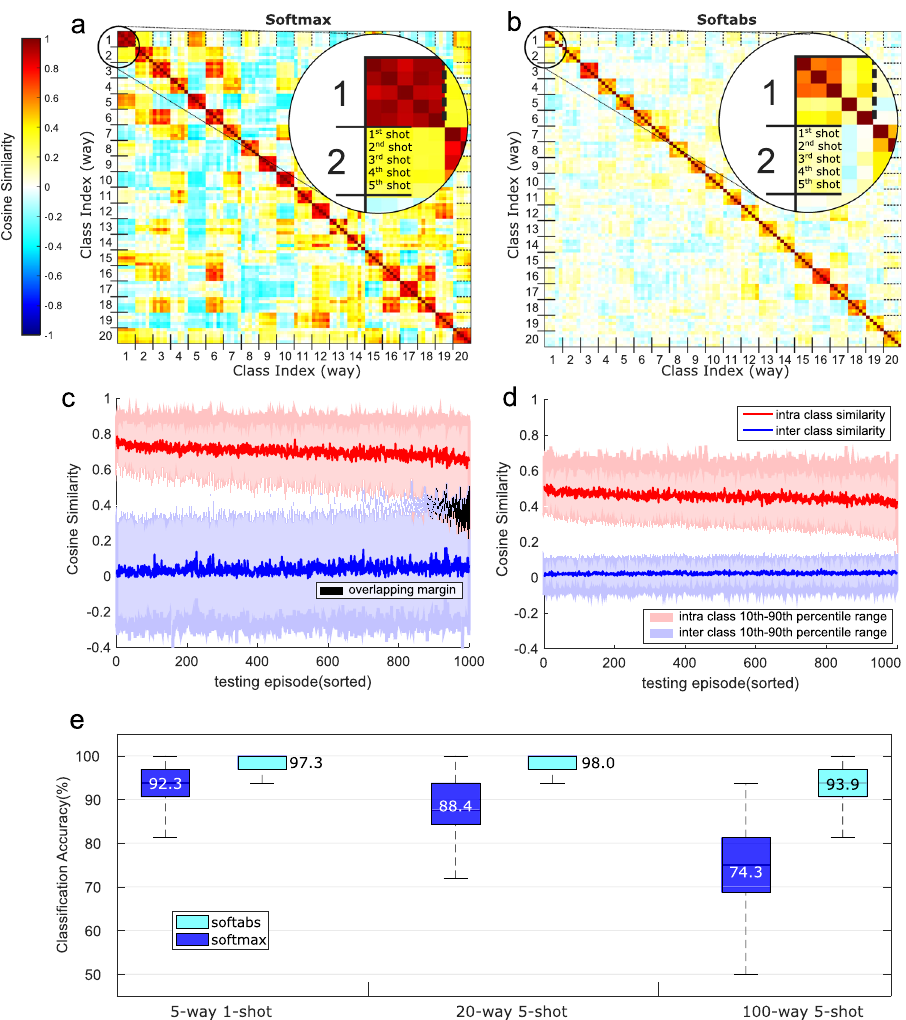
Fig. 3 The role of sharpening functions. The pairwise cosine similarity matrix from the support set of a single testing episode of 20-way 5-shot problem learned using the softmax ( a ) and the softabs ( b ) as the sharpening functions. Intra-class and inter-class cosine similarity spread across 1000 testing episodes in 20-way 5-shot problem with the softmax ( c ) and the softabs ( d ) as the sharpening functions (the episodes are sorted by the intra-class to inter-class cosine similarity ratio highest to lowest). In the case of the softmax sharpening function, the margin between 10th percentile of intra-class similarity and 90th percentile of inter-class similarity is reduced, and sometimes becomes even negative due to overlapping distributions. In contrast, the softabs function leads to a relatively larger margin separation (1.75×, on average) without causing any overlap. The average margin for the softabs is 0.1371, compared with 0.0781 for the softmax. ( e ) Classi fi cation accuracy in the form of a box plot from 1000 few-shot episodes, where each episode consists of a batch of 32 queries. The softabs sharpening function achieves better overall accuracy and less variations across episodes for all few-shot problems. The average accuracy is depicted in each